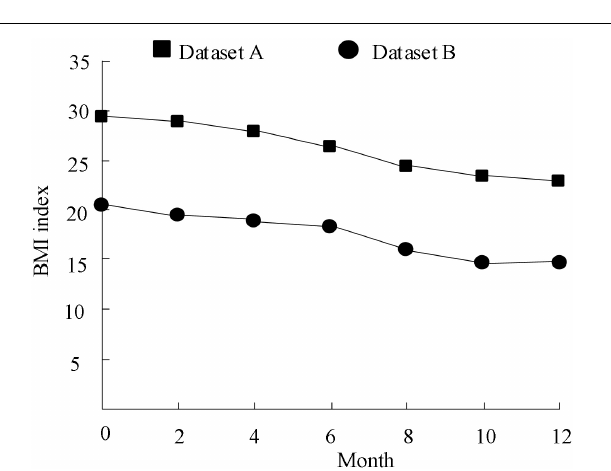
FIGURE 8 | Reliability test results of three methods.